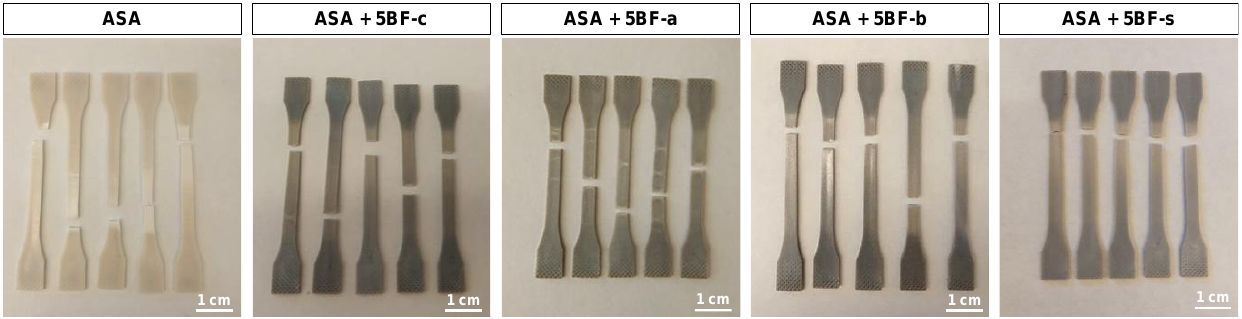
Figure 4. IM samples after the tensile test of ASA and 5 wt% BF composites studied in this work. To gain further insight into the effect of the different treatments applied to the BFs, SEM analysis was done to the different BFs, showed in Figure 5. BF-c and BF-b showed a smooth surface, which seems to indicate that these treatments were not aggressive enough to damage the structure of the BFs. The BF-b treatment did not lead to any significant modification in the BFs, since the mechanical parameters dissected for BF-b are not significantly different to those obtained for BF-c. In the case of BF-a, it shows small cracks in the surface even before compounding the composite. Consequently, these cracks are likely to act as nucleation points of crazes inside the composite during the tension test [37]. This explains the weaker behavior of the BF-a composites observed in Figures 2 and 3, compared to all other composites. SEM image of BF-s show enhanced roughness in the surface and shows some regions where traces of the silane coupling agent can be found. This increases the surface roughness of the fiber, while it also modifies the wettability of the BFs, increasing their hydrophobicity. The combination of these two factors causes an increase in the adhesion between the interface of the BFs with the polymeric matrix, caused by the formation of Si-O covalent bond [35,48]. These results are also in agreement with previous results from other authors, where different fibers were silanized before compounding